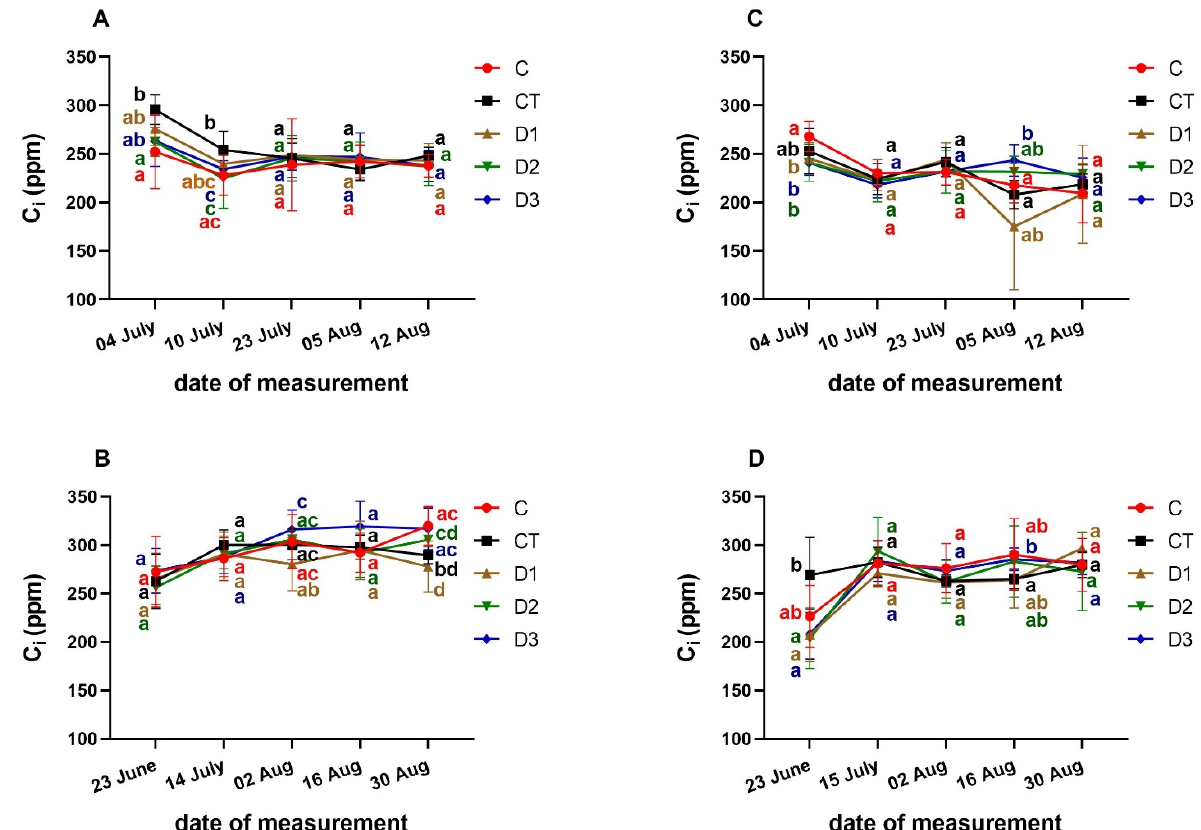
Figure A1. ( A – D ) Effects of treatments on intercellular CO 2 concentration ( C i ; CO 2 ppm) on Chardonnay ( A , B ) and Kékfrankos ( C , D ) varieties in 2013 ( A , C ) and 2014 ( B , D ). Each symbol represents the mean value ± standard deviation (SD). Significance groups of each measurement date are marked with letters ( p < 0.05). The color of letters corresponds to the color of the treatments.